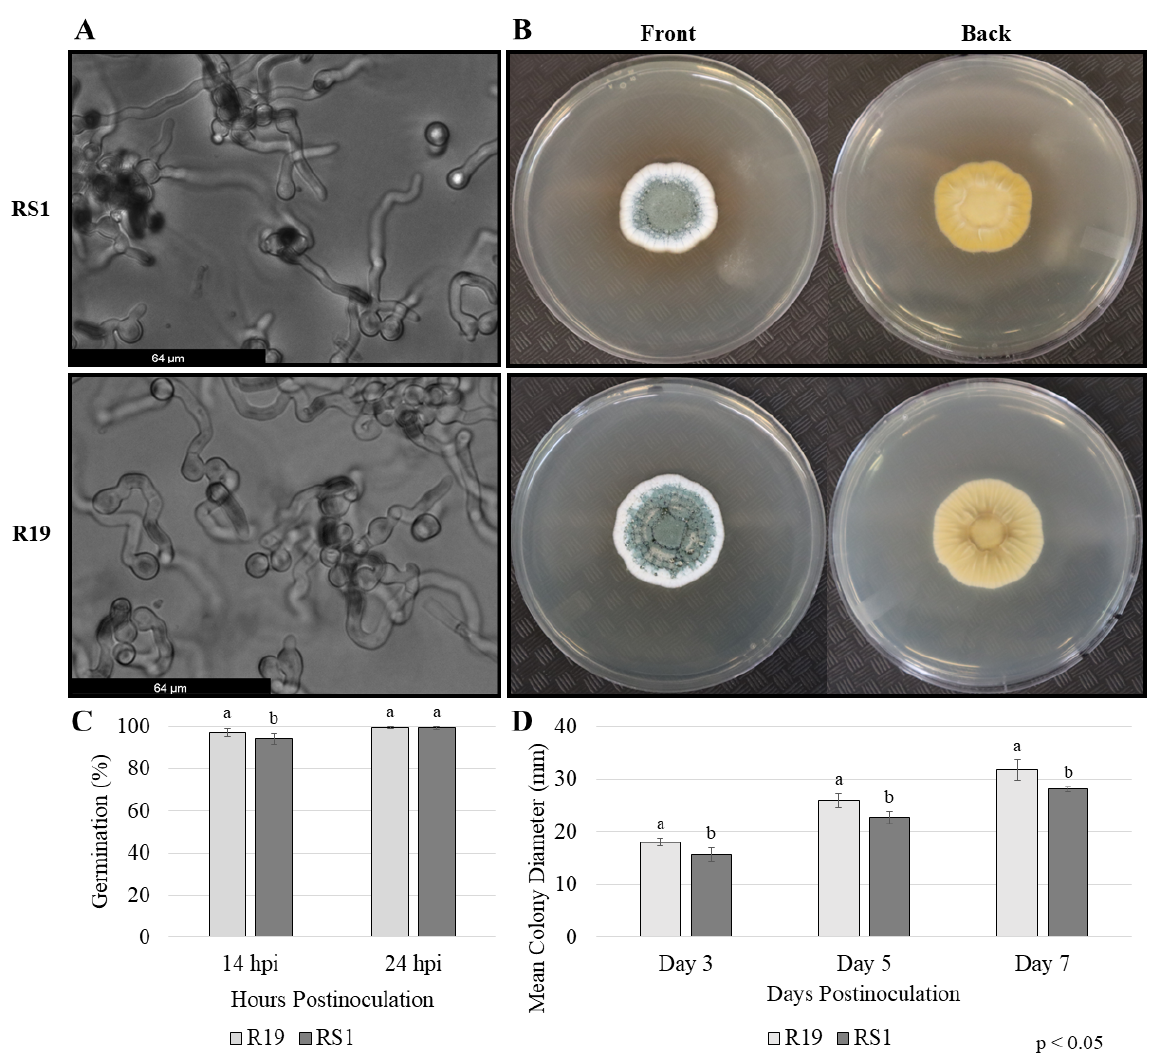
Figure 2. Conidial germination, mycelial growth, and morphology P. expansum R19 and P. polonicum RS1 on Potato Dextrose Agar. ( A ) Germinated conidia at 14 h and 24 h after inoculation. ( B ) Radial growth 7 days after inoculation on Petri plates containing PDA. ( C ) Conidial germination 14 h and 24 h post-inoculation for each strain. ( D ) Mean colony diameters were measured 3, 5, and 7 days post-inoculation on Petri plates containing PDA. Conidial germination was determined by considering only spores with a germ tube at least 2.5 × the size of the conidia. Bars represent the mean of three biological replicates from two trials, and error bars were generated using standard deviation. Different letters on bars denote statistical significance ( p < 0.05), which was determined using a Kruskal–Wallis test and post hoc pairwise Wilcoxon test with Benjamini–Hochberg p -value adjustment. Hpi = hours